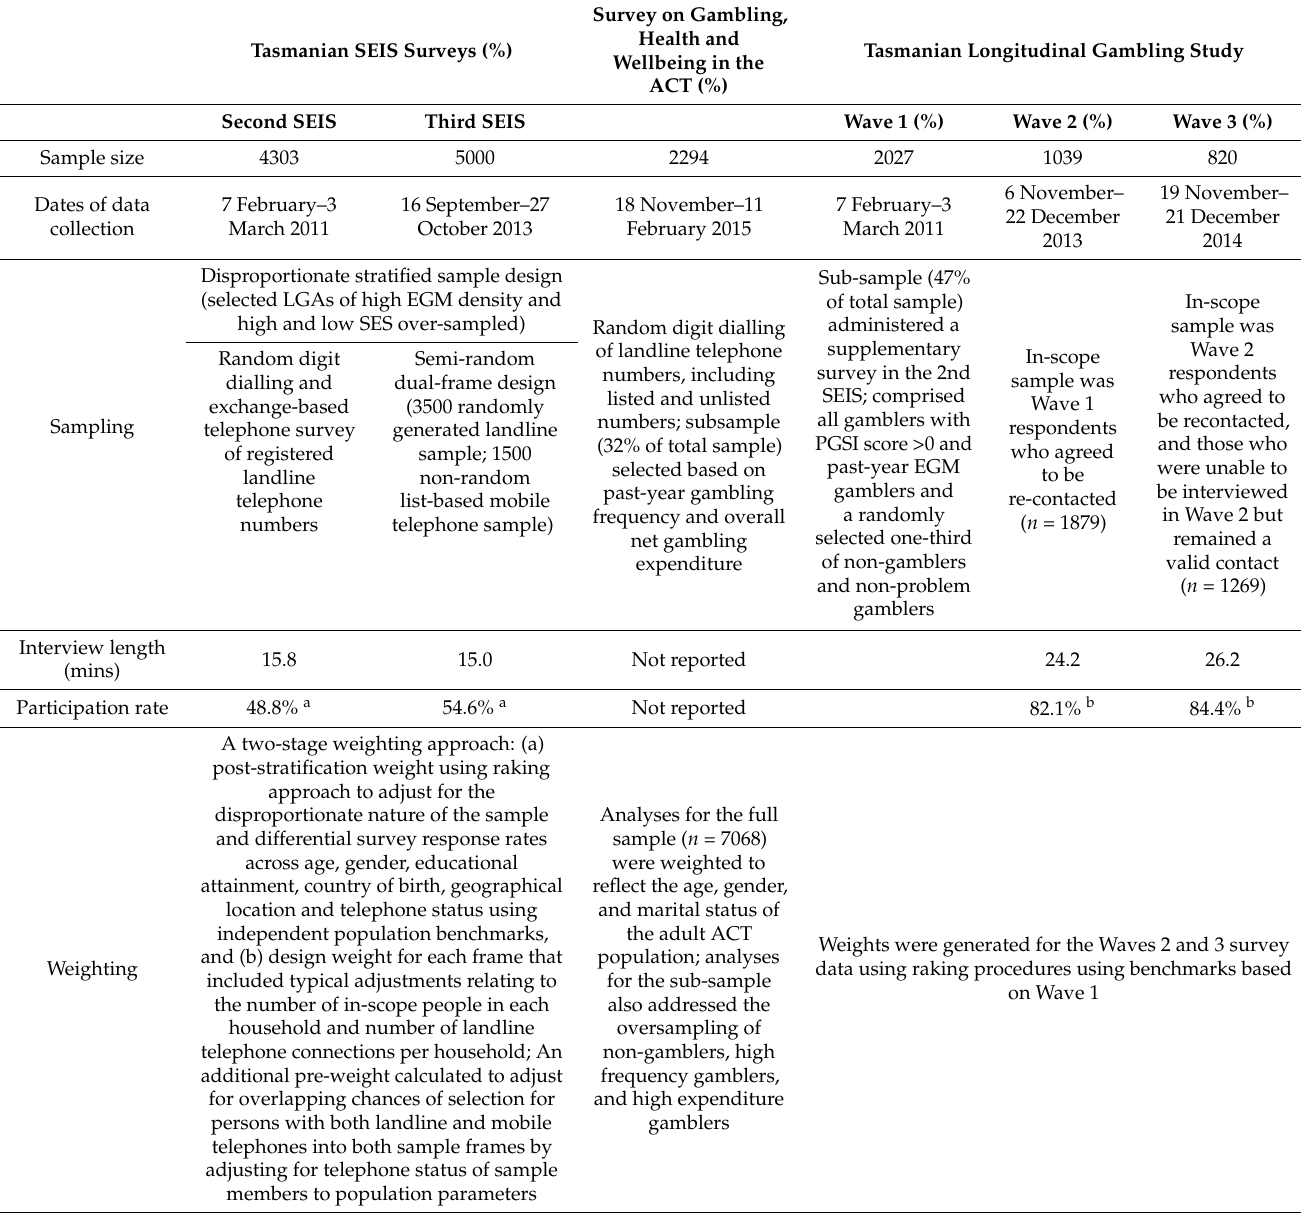
Table 1. Methodological details for the existing datasets employed in this